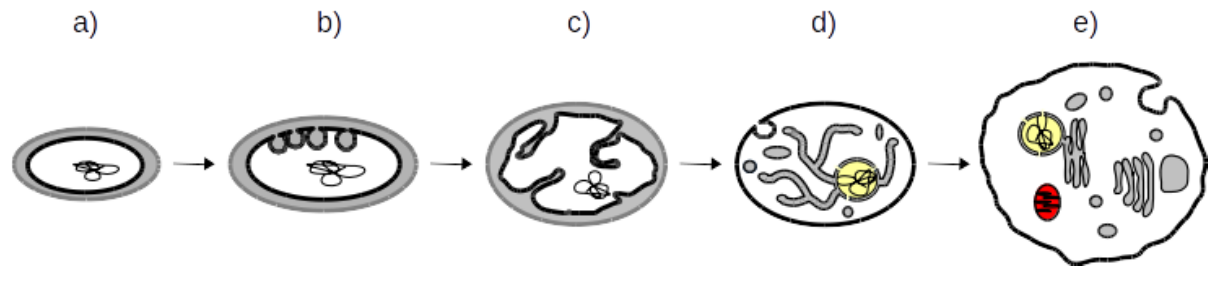
Figure 3. Model for endomembrane system development with TVN as intermediary step. The figure represents schematics of putative intracellular membrane organisations, showcasing the different steps of the proposed hypothesis. Schemas not to scale. DNA is represented as a (wrapped) string. Prokaryotic periplasm is coloured in light grey and cytoplasm in white. Cytoplasmic and inner membranes (IM) are in black, outer membranes (OM) are in light grey. Mitochondrial and nuclear spaces are red and yellow,